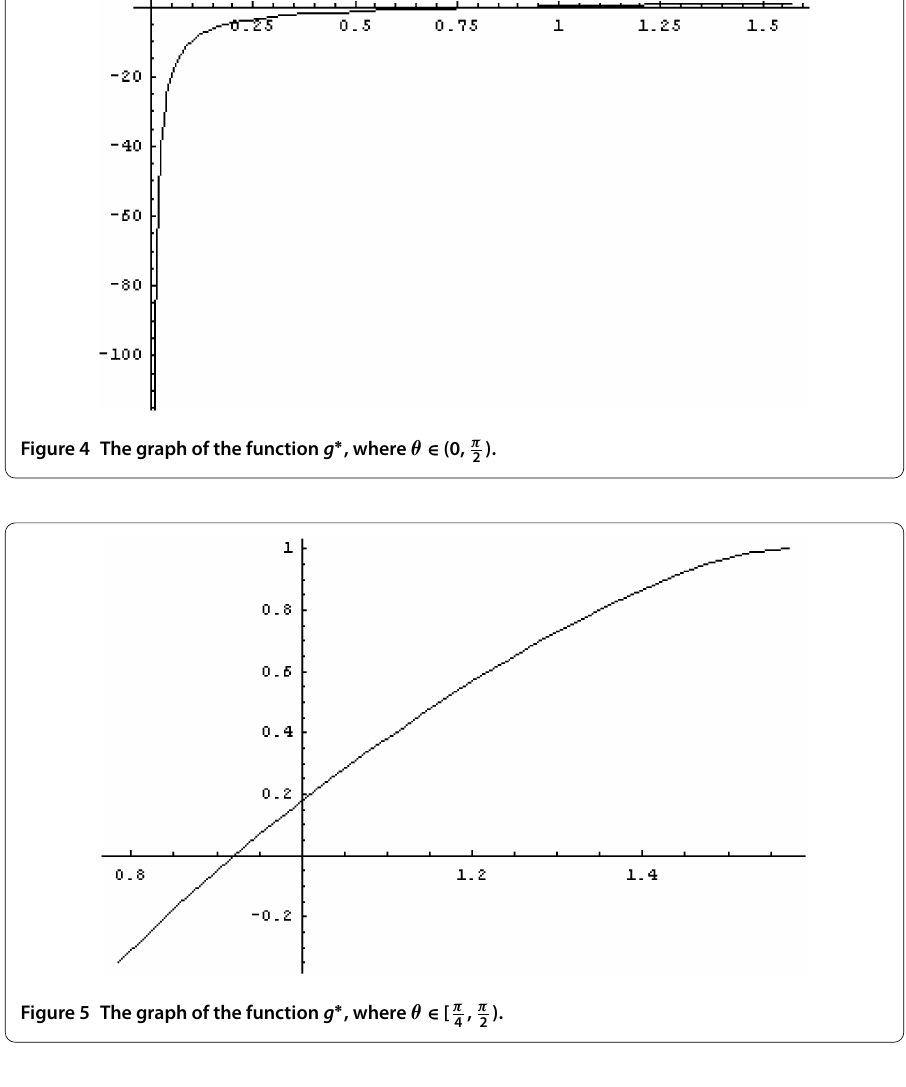
Figure 5 The graph of the function g ∗ , where θ ∈ [ π